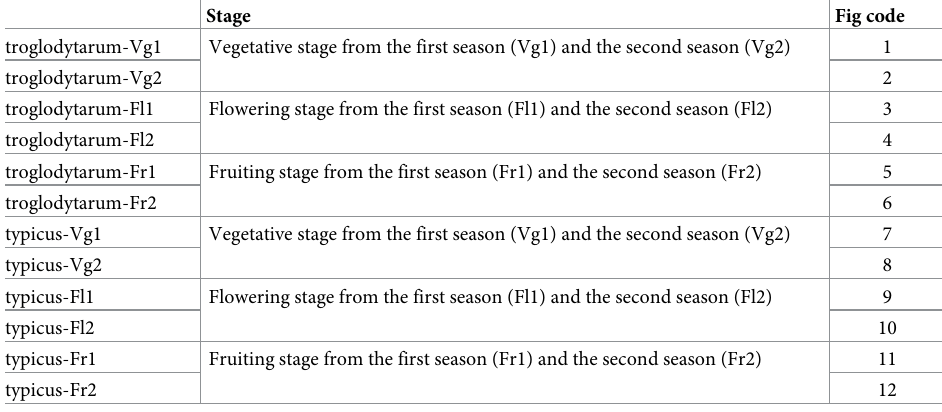
Table 4. Codes used in principal component and heatmapper